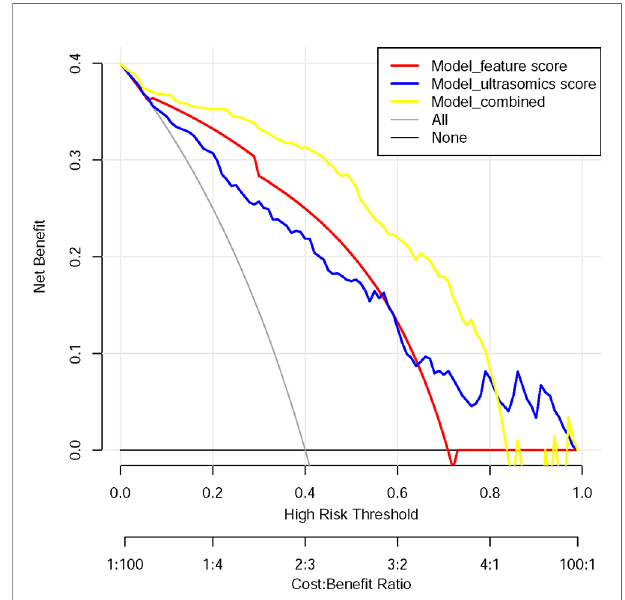
FIGURE 4 | Decision curve analysis for each model. The y-axis measures the net bene fi t. The net bene fi t was calculated by summing the bene fi ts (true positive results) and subtracting the harms (false-positive results), weighting the latter by a factor related to the relative harm of undetected cancer compared with the harm of unnecessary treatment. The combined model (yellow line) had the highest net bene fi t compared with the other two models (blue line and red line) and simple strategies, such as the follow-up of all patients (grey line) or no patients (horizontal black line), across the full range of threshold probabilities at which a patient would choose to undergo a follow-up imaging